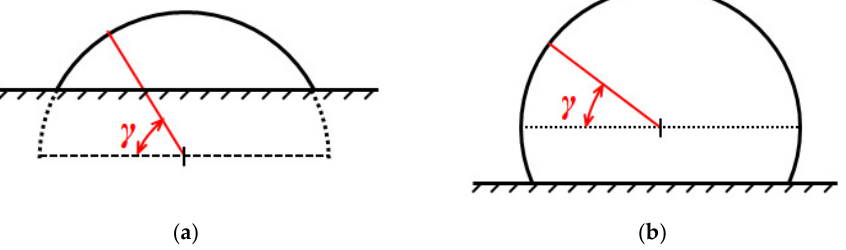
Figure 9. Definition of γ for nonhemispherical structures: ( a ) smaller than hemisphere; ( b ) larger than hemisphere.